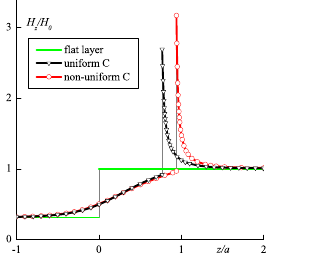
Figure 4. Distribution of the particle concentration over the peak axis ( r = 0 ) and the peak foot ( r = a ) at γ = 1 . 265 .